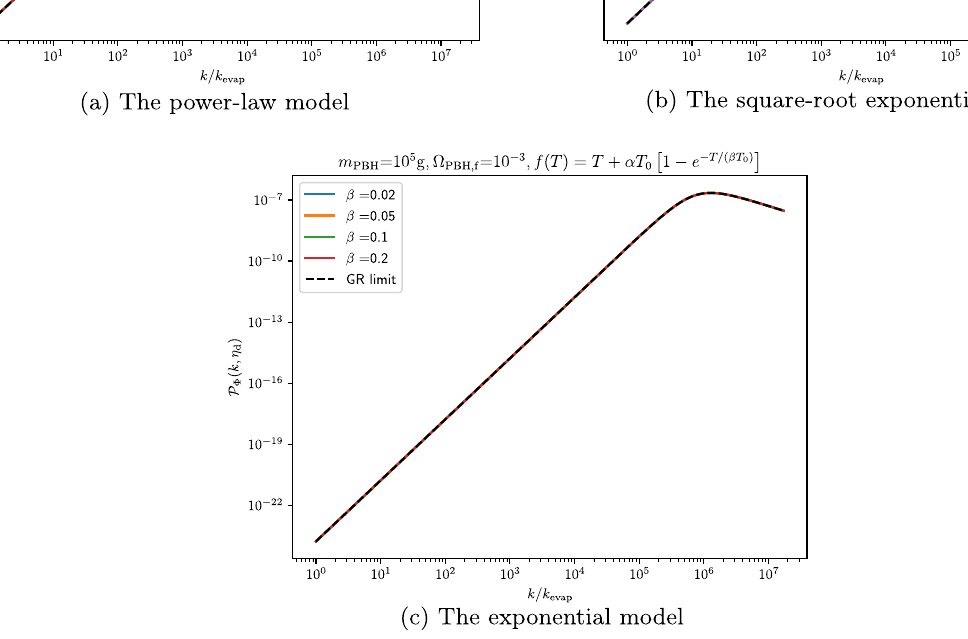
Fig. 3 The power spectrum of the PBH gravitational potential at PBH dominationtime,forthethreemono-parametric f ( T ) models,bychoos- ingdifferentvaluesoftheparameter β withinitsobservationallyallowed